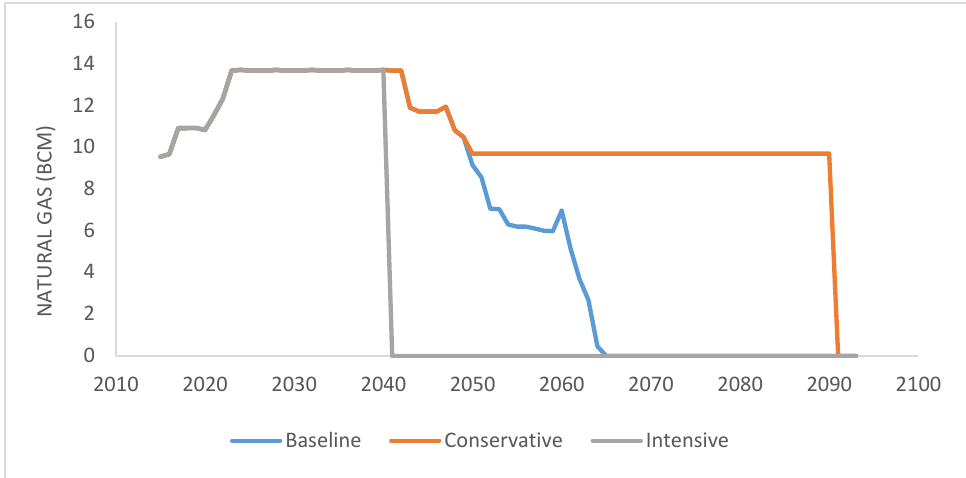
Figure 3. Domestic use of NG for electricity generation under the three scenarios. Table 2. Data assumptions and sources across the three scenarios.